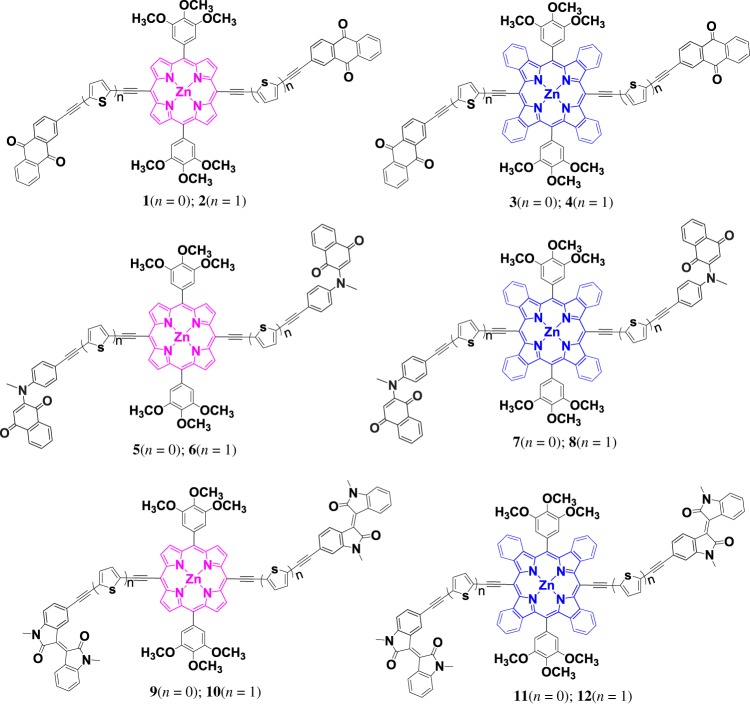
Structures of 1–12.